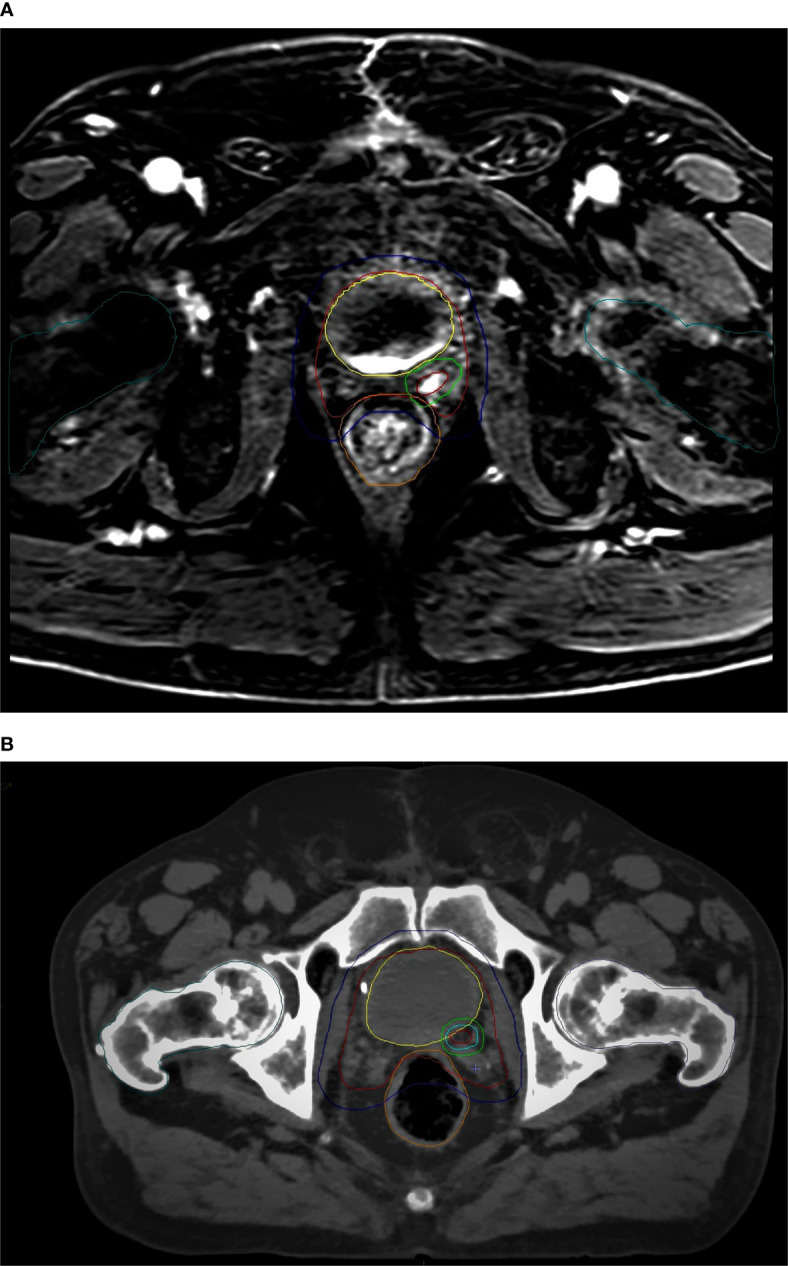
mpMRI-based (A)
vs CT-based (B) CTV/PTV (prostate bed) and OARs delineation: red, CTV (prostate bed); blue, PTV (prostate bed); yellow, bladder; orange, rectum; dark green, femoral heads.